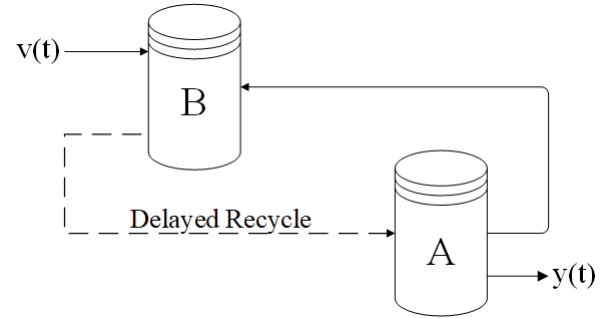
Figure 13. Cascade chemical reactor system with Reactors A and